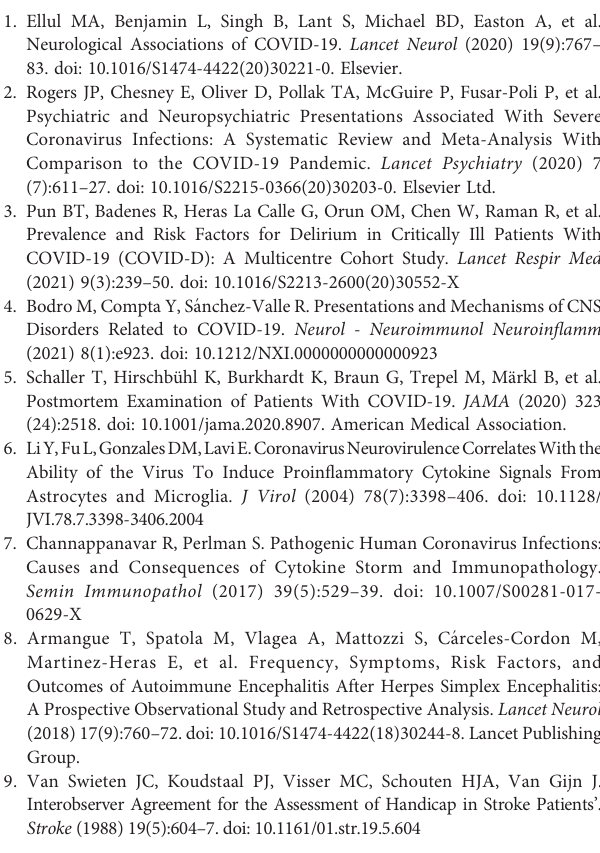
Supplementary Table 1 | Clinical features of patients with encephalopathy and encephalitissyndromes associated to COVID-19. EEG,electroencephalogram;ICU, intensive care unit; IQR, interquartile range; MRI, magnetic resonance imaging; mRS, modi fi edRankin Scale; WBC, white blood cells. (A) Two cases compatiblewith acute disseminatedencephalomyelitis (ADEM)and 2 with limbicencephalitis, but none with acutenecrotizingencephalopathy(ANE). (B) Threewithmultifocalmyoclonusand1with akinetic-rigid syndrome. (C) Three with multifocal cortical/subcortical T2/FLAIR hyperintenselesionsinthecerebralhemispheres,basalgangliaand/orbrainstem;2with